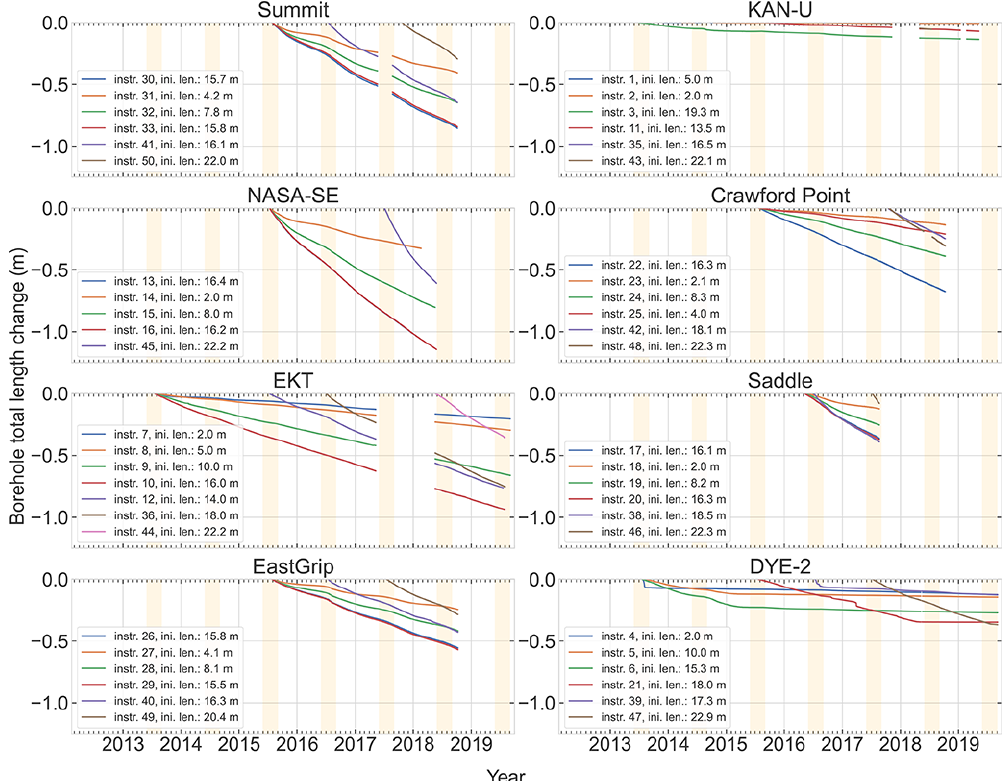
Figure 4. Borehole length changes. The legend indicates the ID of each instrument as reported in Table 2 and the initial length of each borehole. June–July–August are highlighted in orange.